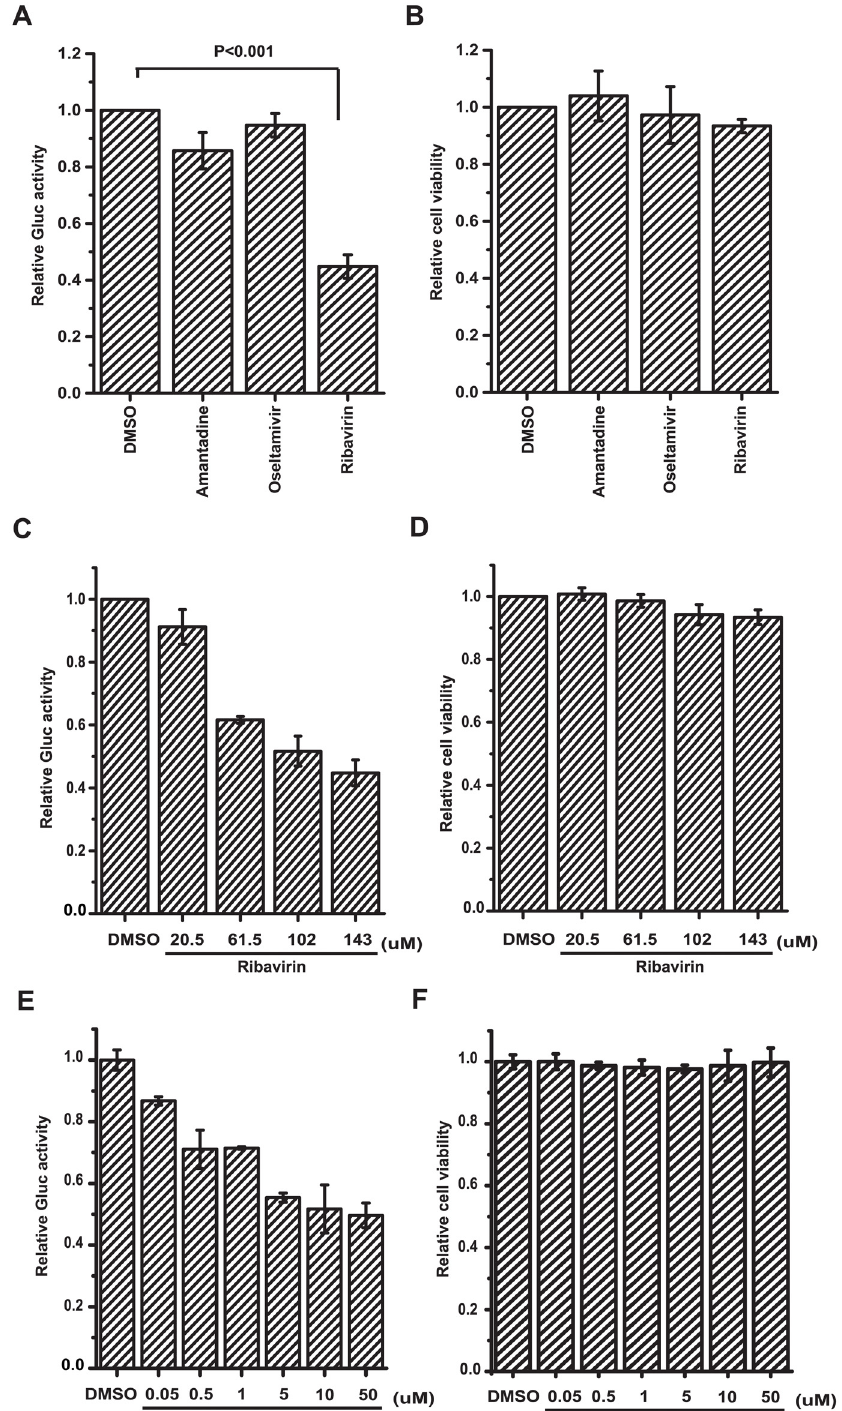
Fig 5. Inhibitory effects of known anti-influenza compounds on IAV minigenome transcription/ replication system in A549-5Ps cells. (A-B) Inhibitory effects of amantadine hydrochloride, oseltamivir phosphate and ribavirin. A549-5Ps cells were treated with indicated compounds (50 μ M amantadine hydrochloride, 300 μ M oseltamivir phosphate or 143 μ M ribavirin) for 72 hours. (A) Gluc activity in supernatants was quantified. (B) Cell viability was analyzed using CCK-8 reagent. (C-D) Effects of